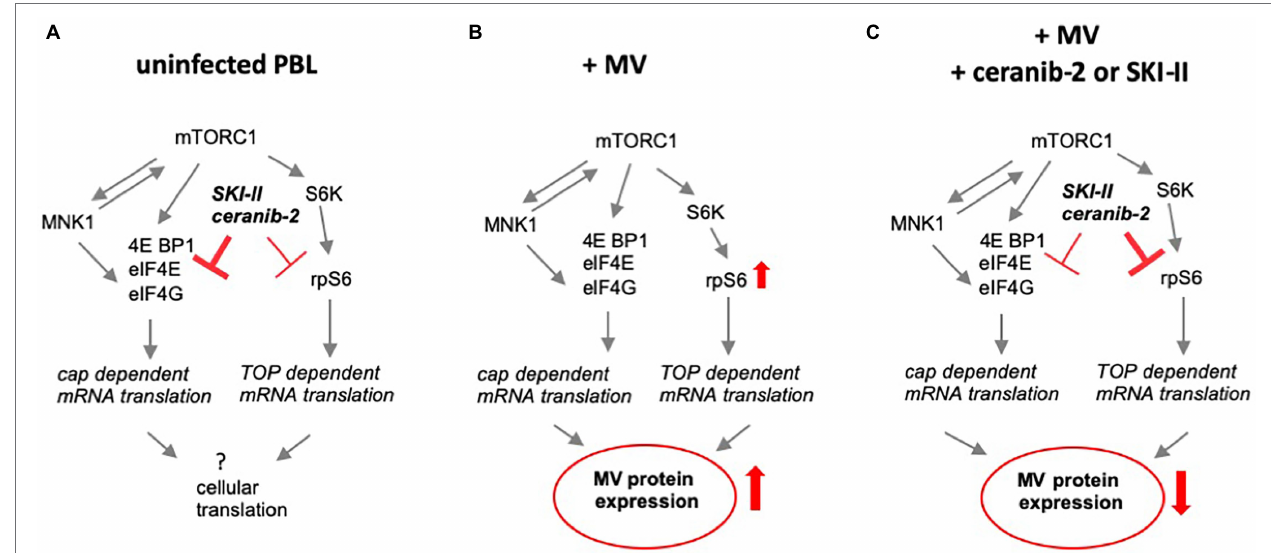
FIGURE 4 | Schematic summary of the major findings. (A) Schematically summarizes the observed effects of ceranib-2 and SKI-II in uninfected PBL, (B) shows the effect of MV infection on these signaling pathways, and (C) the effects of the two inhibitors on infected PBL. Whereas in uninfected cells, the major effect was found on the phosphorylation of eIF4E, in MV-infected cells ceranib-2 and SKI-II predominantly neutralize the effect of the infection and reduce rpS6 expression below levels in untreated control